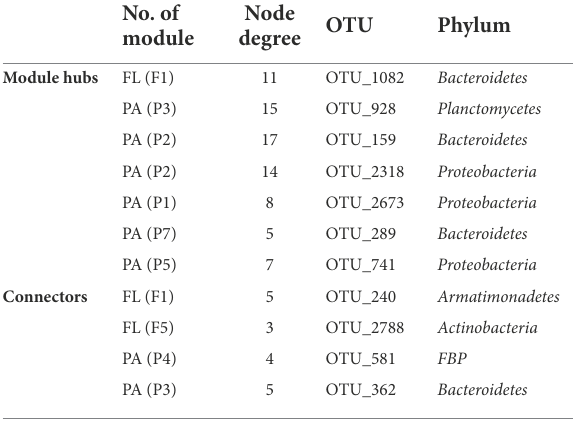
TABLE 2 Module hubs and connectors in the Network analysis of FL and PA groups. No. of